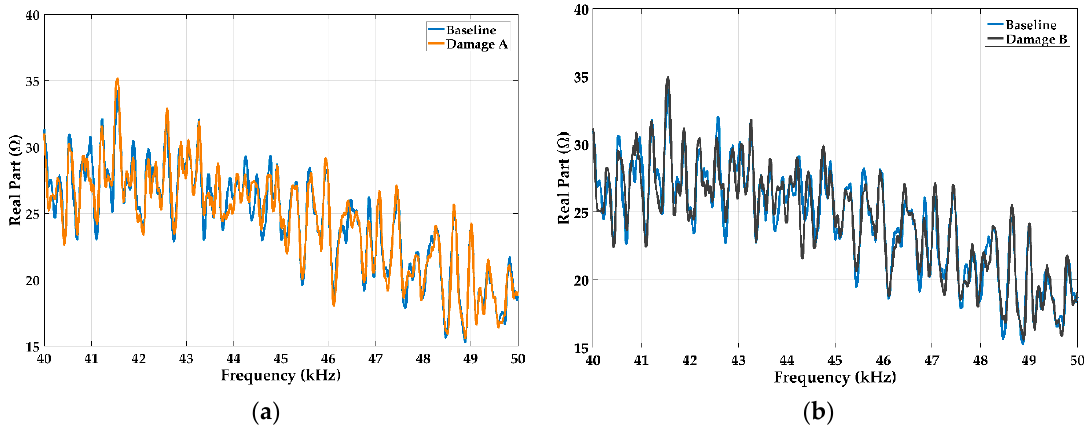
Figure 3. Impedance signatures for damage ( a ) A and ( b ) B at 0.5 m from the transducer.